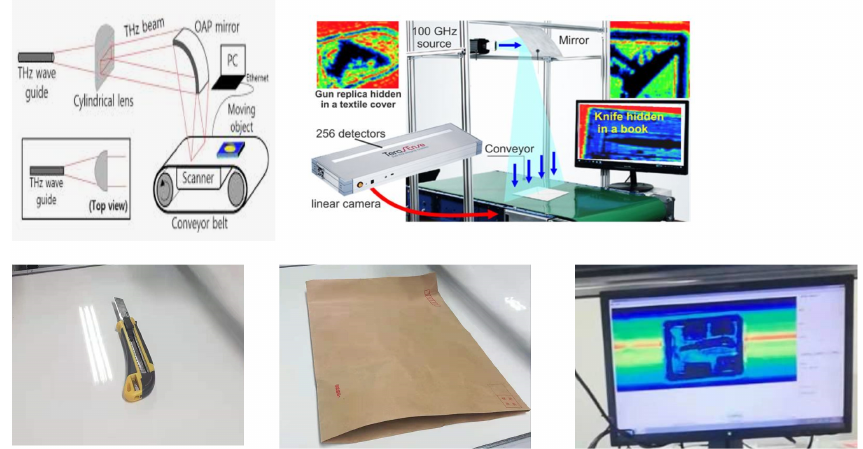
Figure 2. THz-scanned imaging system for security screening application.